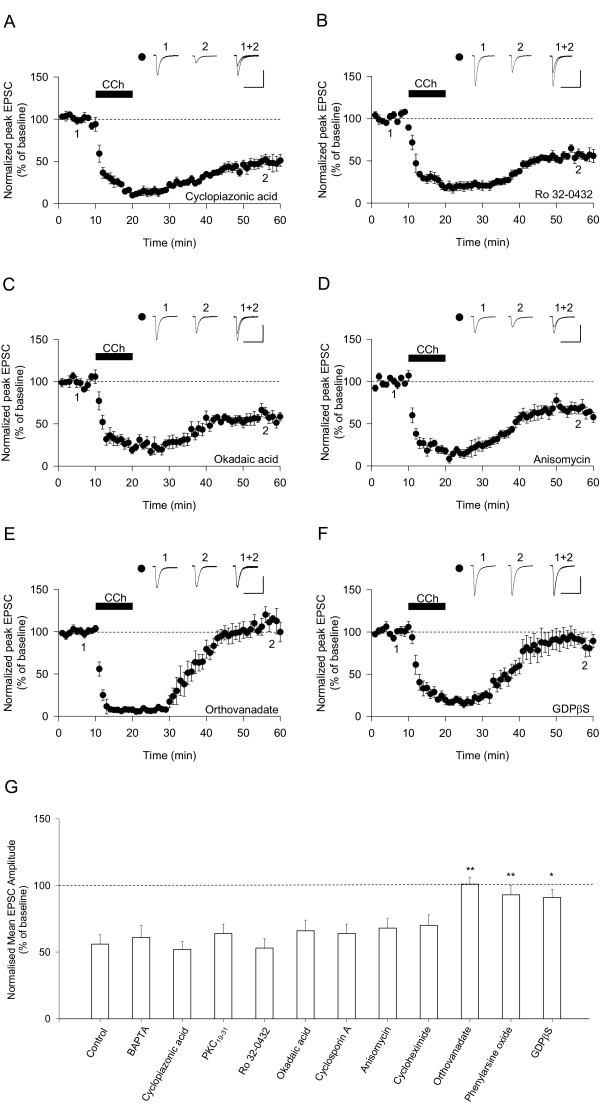
Signalling mechanisms involved in mAChR-LTD. (A) Cyclopiazonic acid (2 μM) has no effect on mAChR-LTD (n = 6). (B) Ro 32-0432 (10 μM) has no effect on mAChR-LTD (n = 6). (C) Okadaic acid (100 nM) has no effect on mAChR-LTD (n = 5). (D) Anisomycin (20 μM) has no effect on mAChR-LTD (n = 7). (E) Orthovanadate (100 μM) prevents the induction of mAChR-LTD (n = 5). (F) GDPβS (1 mM) blocks the induction of mAChR-LTD (n = 6). (G) A summary of results from control (n = 8), BAPTA (n = 9), cyclopiazonic acid (n = 6), PKC19–31 (n = 9), Ro 32-0432 (n = 6), okadaic acid (n = 5), cyclosporin A (n = 7), anisomycin (n = 7), cycloheximide (n = 7), orthovanadate (n = 5), phenylarsine oxide (n = 7) and GDPβS (n = 6), experiments. * P < 0.05 vs control ** P < 0.01 vs control.